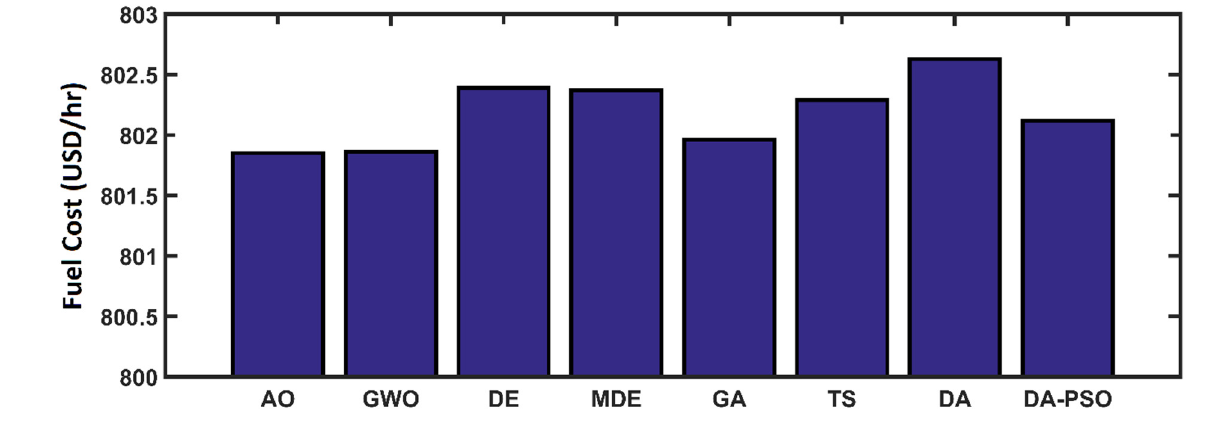
Figure 5. Convergence curve for IEEE ‐ 30 bus system using AO.